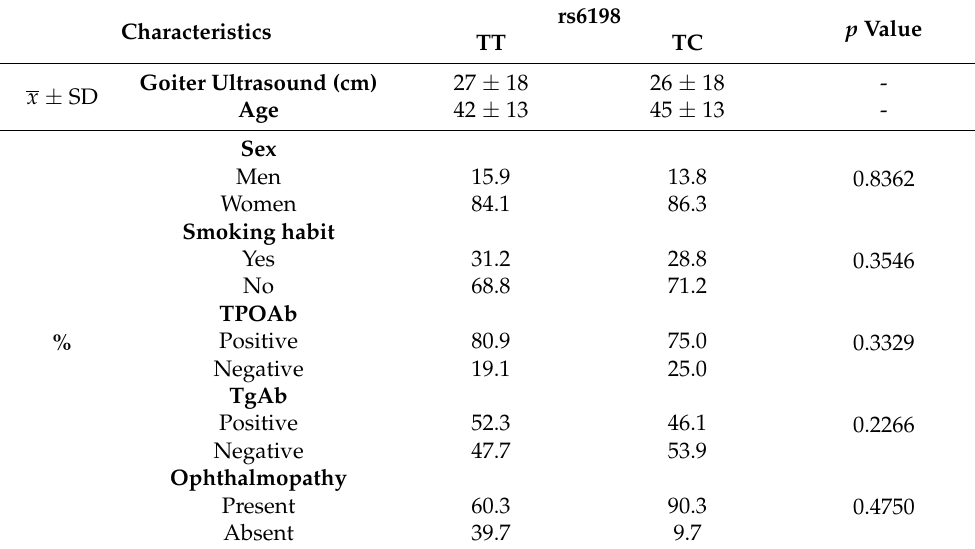
Table 2. Clinical features of 384 Graves’ disease patients with different genotypes of NR3C1